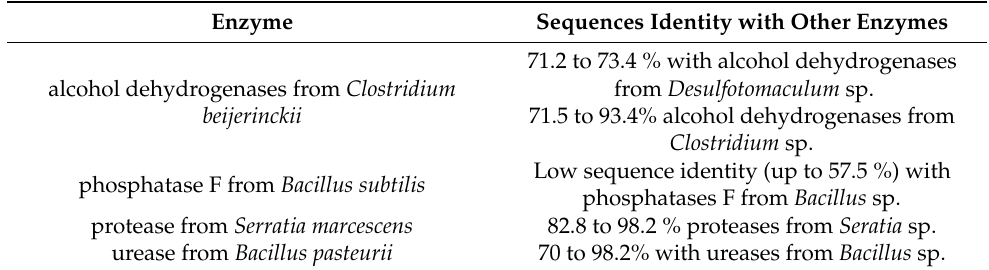
Table 4. Enzymes illustrating high sequence similarity with those considered in molecular docking study and that are potentially affected by the presence of